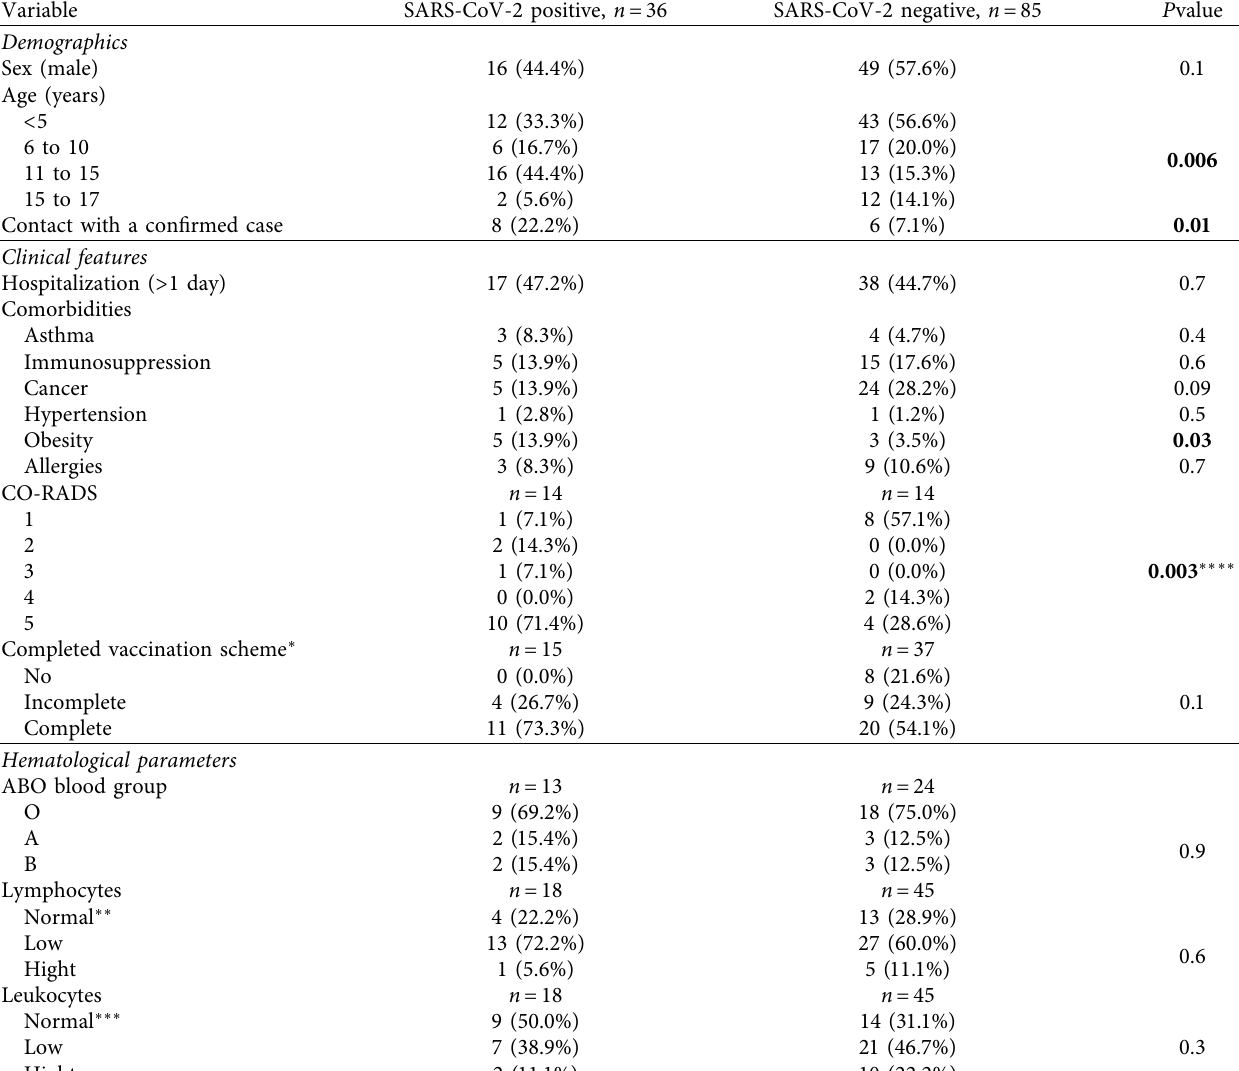
Table 1: Comparison of demographics, clinical features, comorbidities, and hematological parameters between SARS-CoV-2 positive and negative pediatric